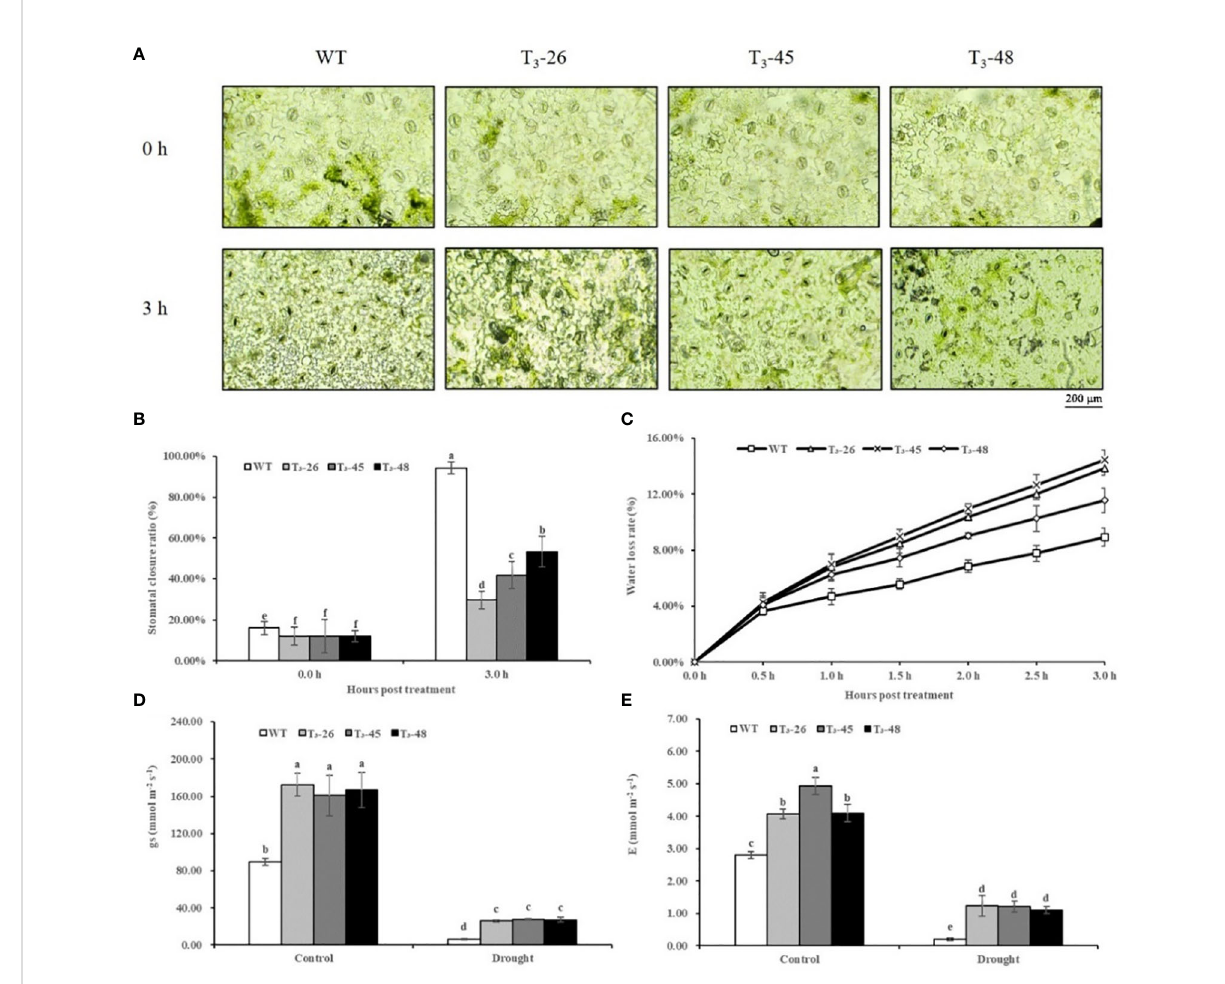
FIGURE 6 NtCPS2 functions in drought tolerance. (A) Stomata of WT and transgenic plants under desiccation treatment. Scale bar =200 m m. (B) Ratio of stomata of WT and transgenic lines after dehydration. (C) Water loss rates of leaves detached from WT and transgenic lines. (D) Stomatal conductance (gs) of WT and transgenic lines after 6 h of drought treatment. (E) Transpiration rate (E) of WT and transgenic plants after 6 h of drought treatment. Error bars represent means ± SD. Statistical analysis was performed using the ANOVA test (p< 0.05) and signi fi cant differences are indicated by different